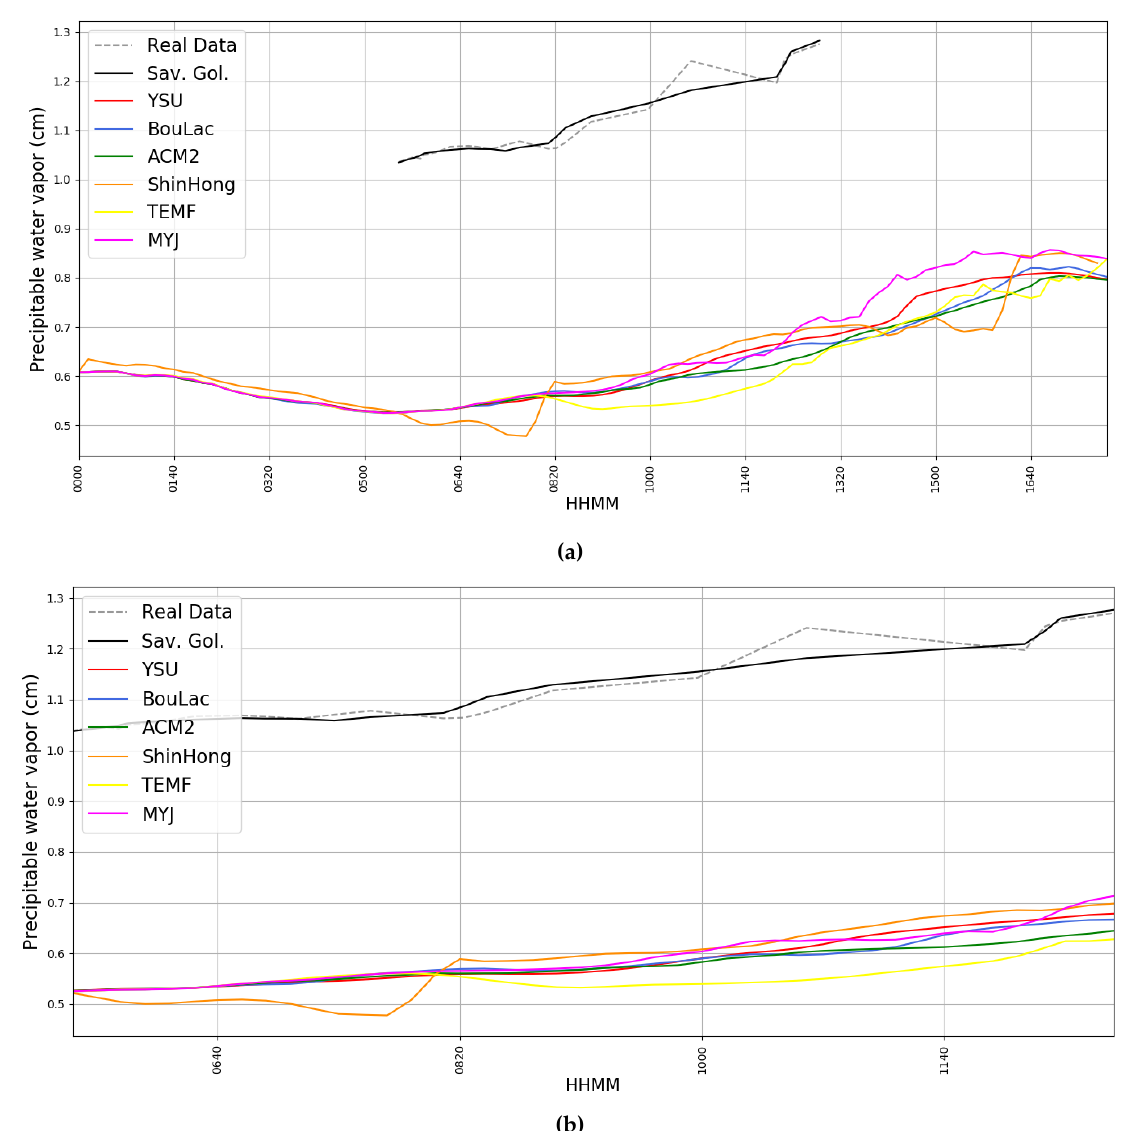
Figure 17. ( a ) Simulated WV timeseries compared with photometer-retrieved WV timeseries, 04 / 04 / 2016, dotted grey: real data, black: Savitsky–Golay smoothing of real data, red: simulated data with YSU parametrization, blue: simulated data with BouLac parametrization, green: simulated data with ACM2 parametrization, orange: simulated data with ShinHong parametrization, yellow: simulated data with TEMF parametrization, purple: simulated data with MYJ parametrization. ( b ) Simulated WV timeseries compared with photometer-retrieved WV timeseries, zoomed-in, 04 / 04 / 2016, dotted grey: real data, black: Savitsky–Golay smoothing of real data, red: simulated data with YSU parametrization, blue: simulated data with BouLac parametrization, green: simulated data with ACM2 parametrization, orange: simulated data with ShinHong parametrization, yellow: simulated data with TEMF parametrization, purple: simulated data with MYJ parametrization.